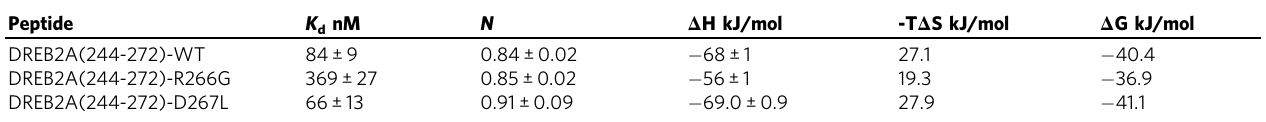
Table 3 Thermodynamics of DREB2A(244-272) variants binding to RCD1-RST(499-572). Peptide K d